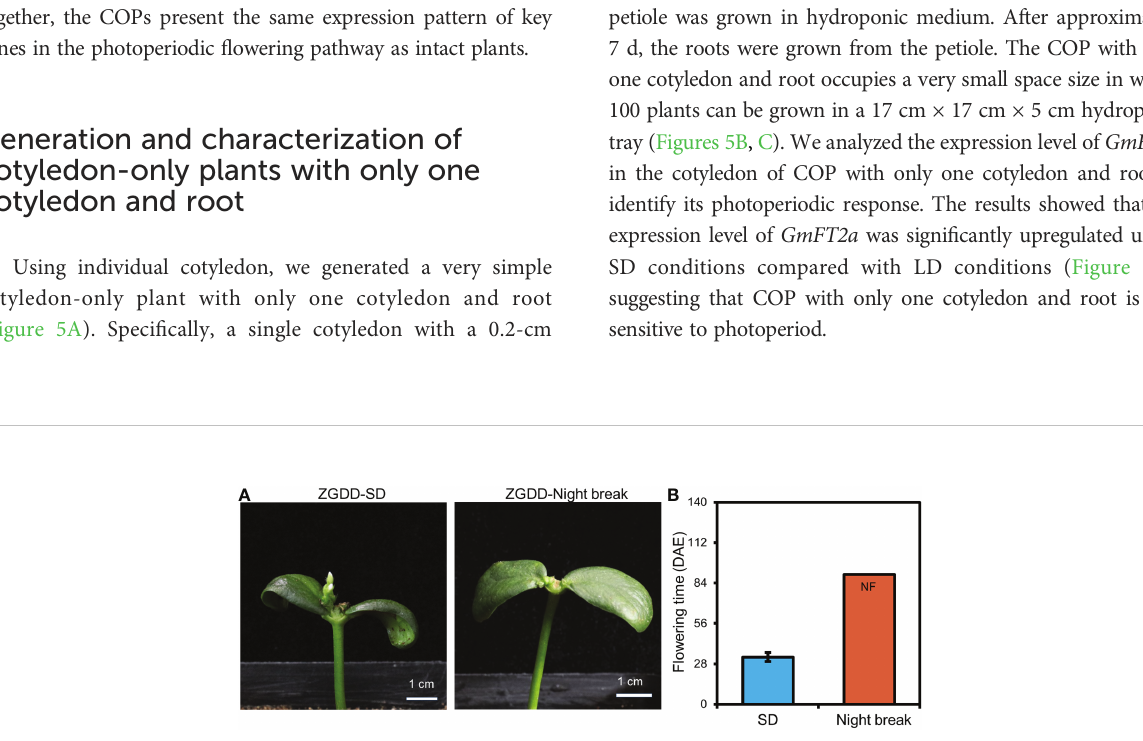
Values represent means ± standard deviation. Five plants were recorded for each treatment.